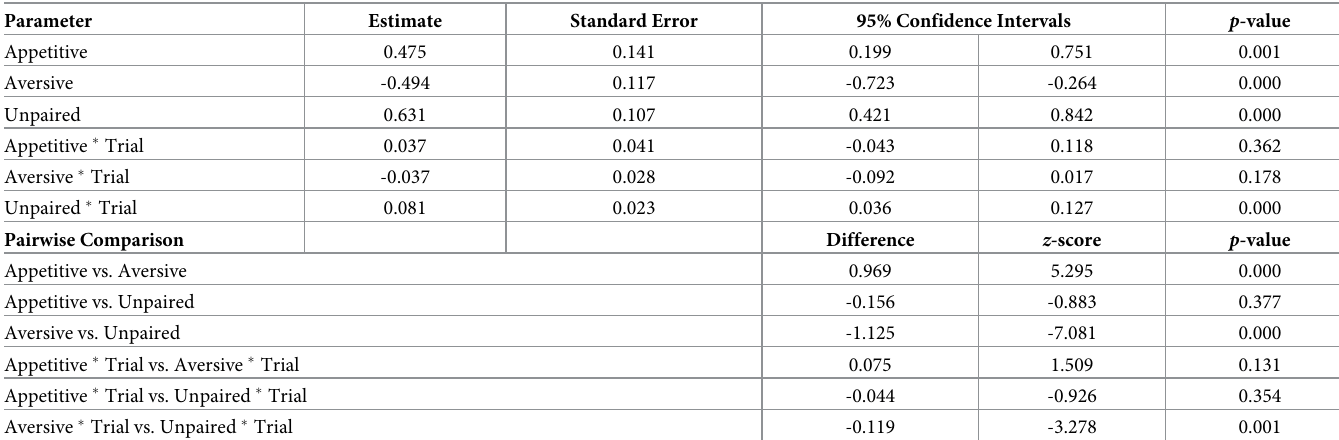
Table 1. Experiment 1 conditioning US approach